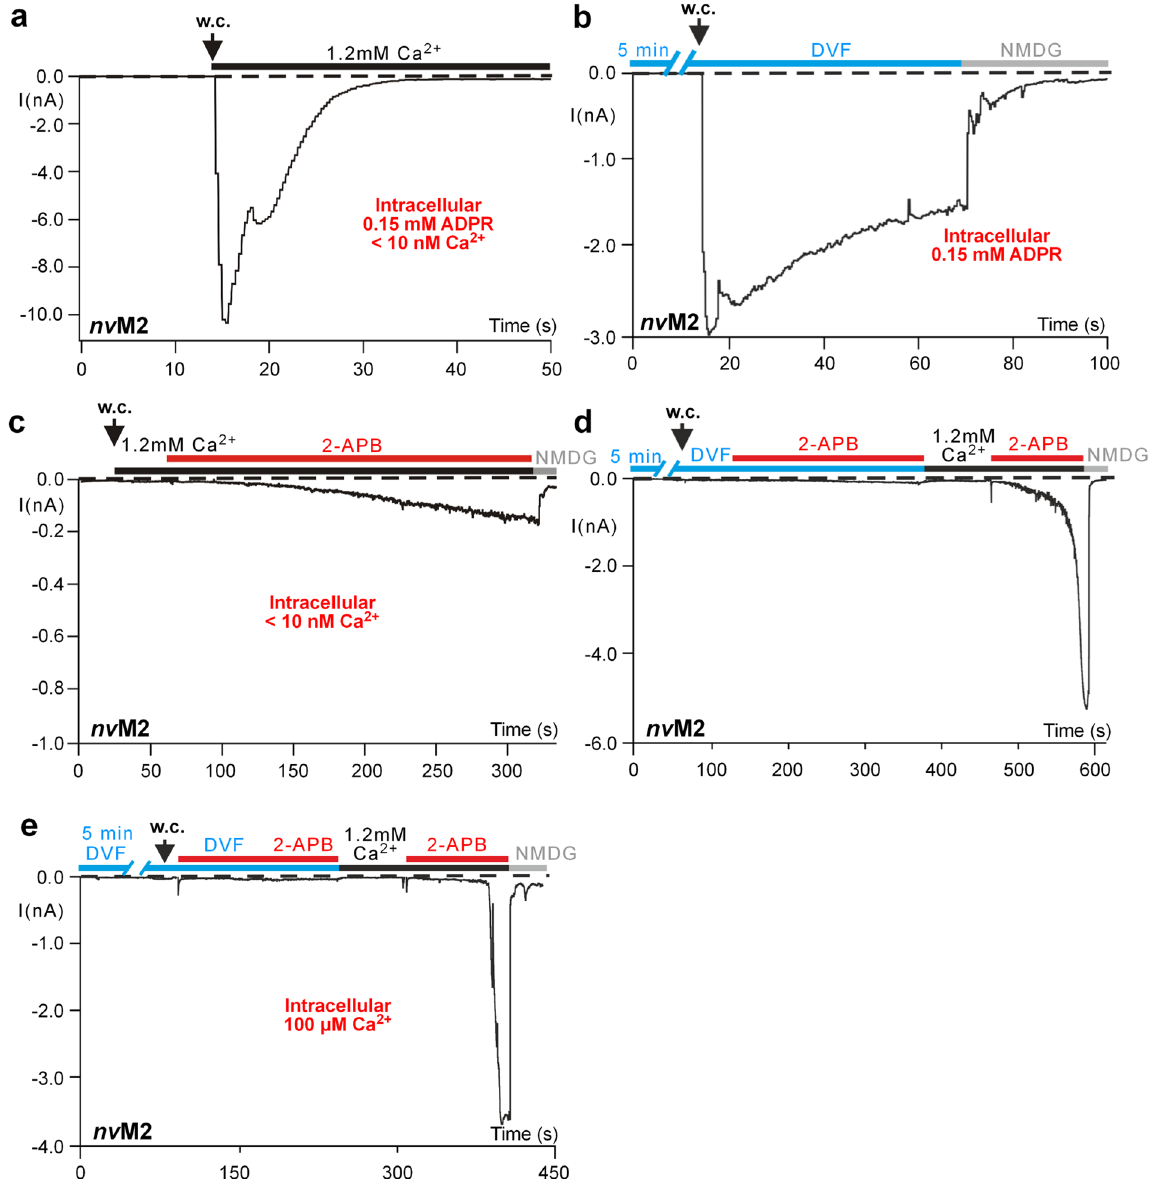
Figure 3. Dependence on Ca 2 + of currents induced by ADPR or 2-APB in nv TRPM2. ( a ) For the stimulation with ADPR, intracellular Ca 2 + is not required. The experiment was performed in standard bath (1.2 mM Ca 2 + ) but with a pipette solution in which Ca 2 + was buffered with EGTA to below 10 nM as indicated. ( b ) Extracellular Ca 2 + is not required for the ADPR-dependent stimulation, but for the current inactivation. The current recording was performed with a pipette solution containing 1 µ M Ca 2 + but in the extended absence of extracellular Ca 2 + , achieved by multiple superfusion of the cells with a divalent-free solution. Note that the inactivation takes place considerably slower than under control conditions (inset Fig. 1a), reaching about 50% of the maximal current after 40 s. ( c ) Intracellular Ca 2 + is required for the stimulation with 2-APB. Under the same Ca 2 + conditions as in panel a (no ADPR), 2-APB (1 mM) induced only miniscule currents. ( d ) Extracellular Ca 2 + is required for the stimulation with 2-APB. After extended exposure to DVF, 2-APB (1 mM) was without effect but did induce characteristic currents when applied a second time in the presence of a standard extracellular Ca 2 + (1.2 mM). As in panel b, the pipette solution contains 1 µ M Ca 2 + . ( e ) Strongly elevated intracellular Ca 2 + cannot substitute extracellular Ca 2 + . Same experimental conditions as in panel d, but the intracellular solution contained 100 µ M Ca 2 + . All experiments were repeated at least three times confirming the